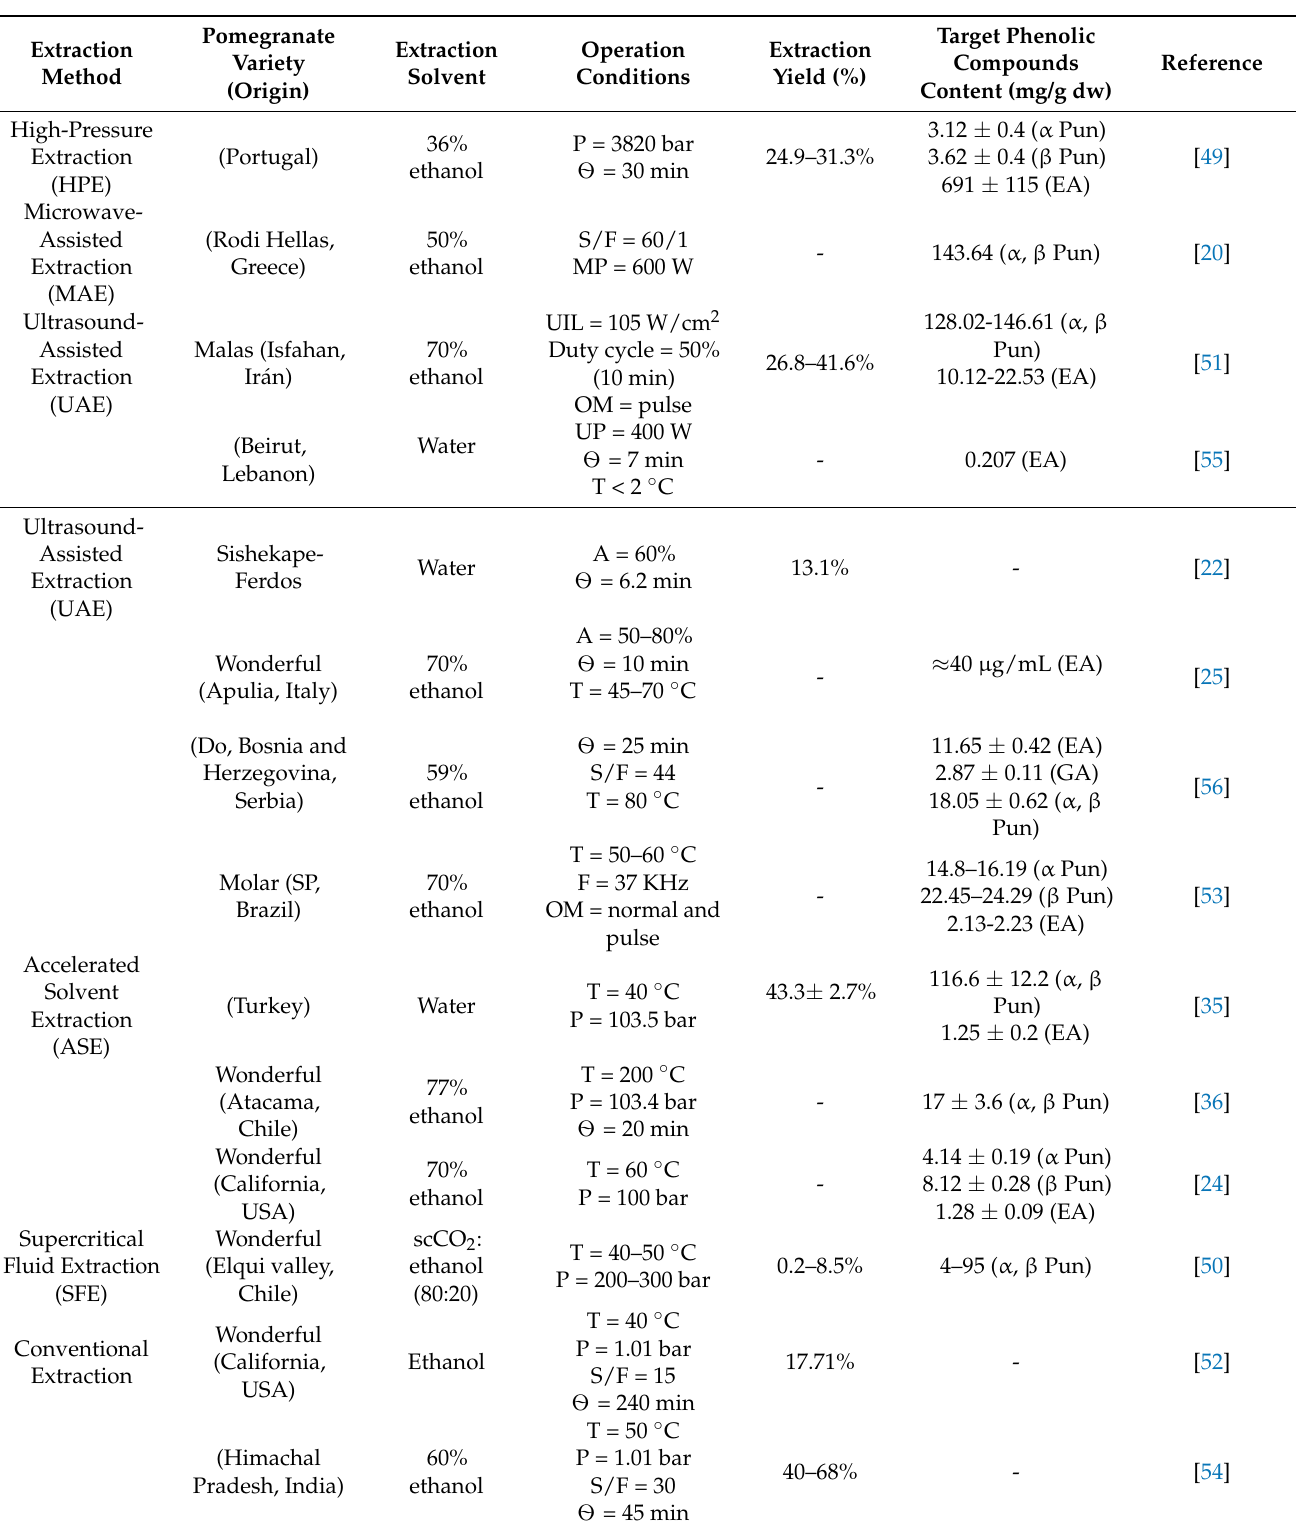
Table 2. Extraction of phenolic compounds from pomegranate peel applying green and conventional extraction